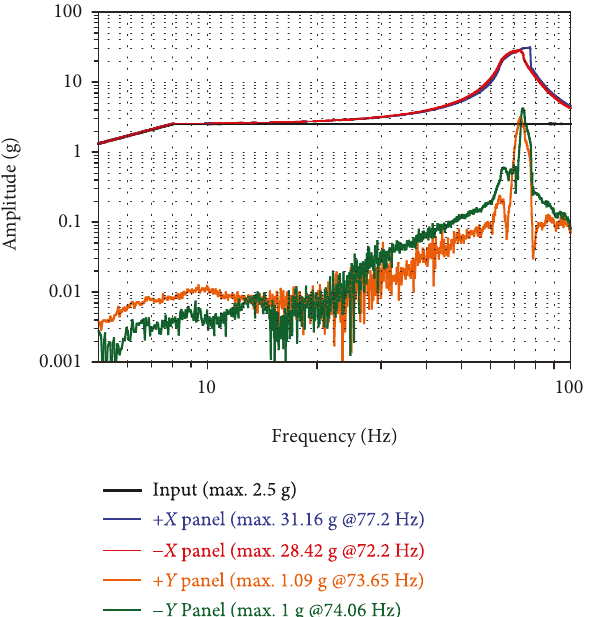
Figure 11: Sine vibration test results of the mechanism along the x -axis excitation.